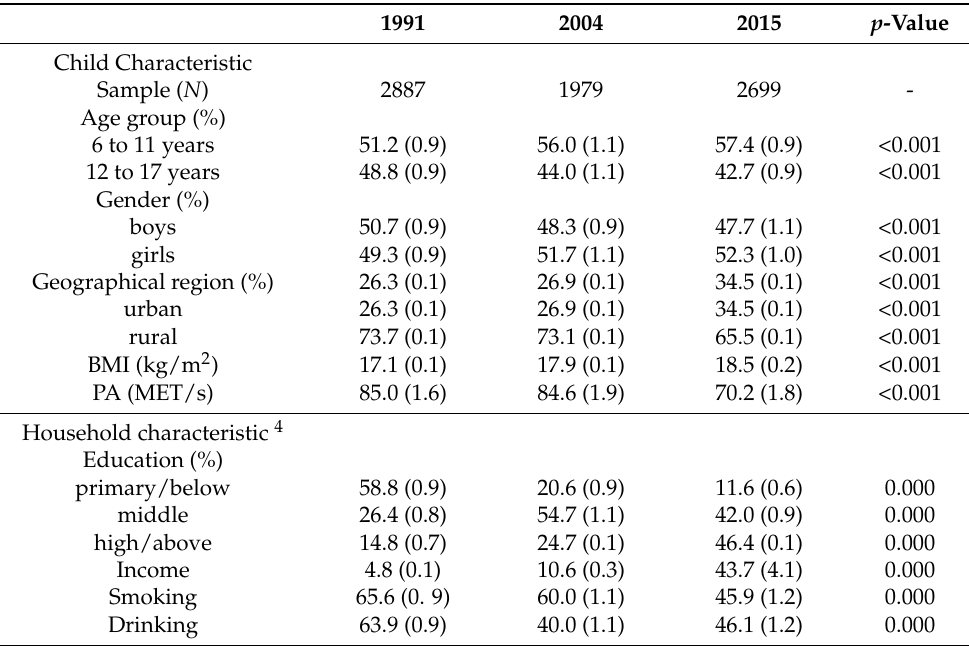
Table 1. Sociodemographic characteristics of participants by CHNS rounds, 1991 to 2015 1–3 .